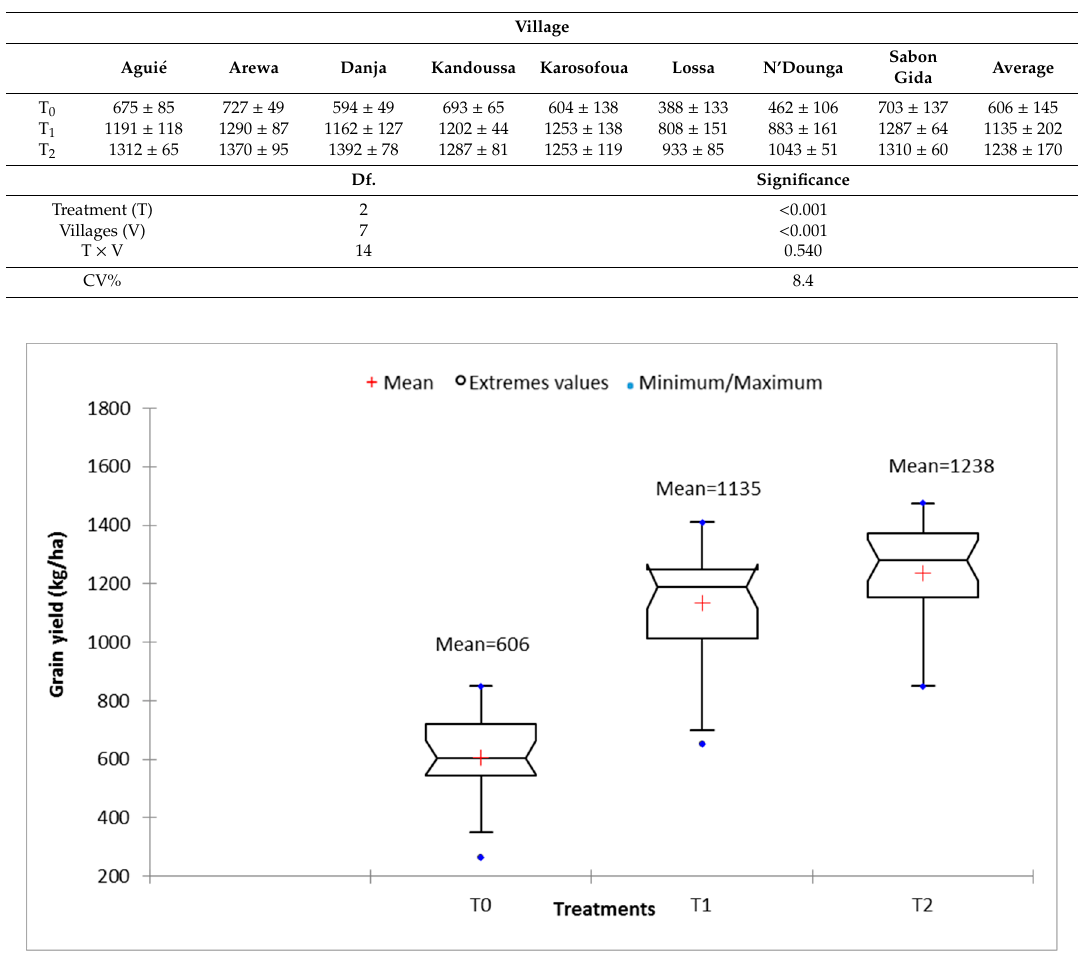
Figure 6. Effects of the treatments on grain yield (kg ha − 1 ) in the on-farm experiments. Figure 6. E ff ects of the treatments on grain yield (kg ha − 1 ) in the on-farm